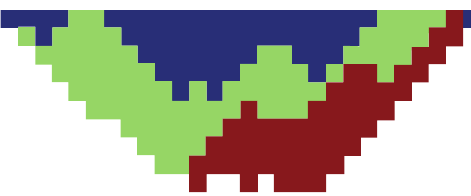
Figure 3: Feasible solution in terms of the required slope angles (45 ∘ in this case) after applying the normalization procedure.